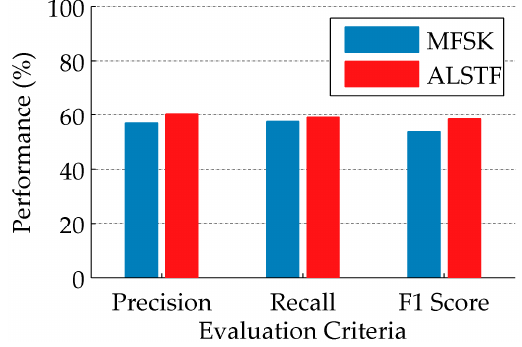
Figure 10. Performance comparison between MFSK and the proposed feature on the CAD-60 dataset in one-shot learning setting. Precision, recall and F1 score are used as accuracy measure.